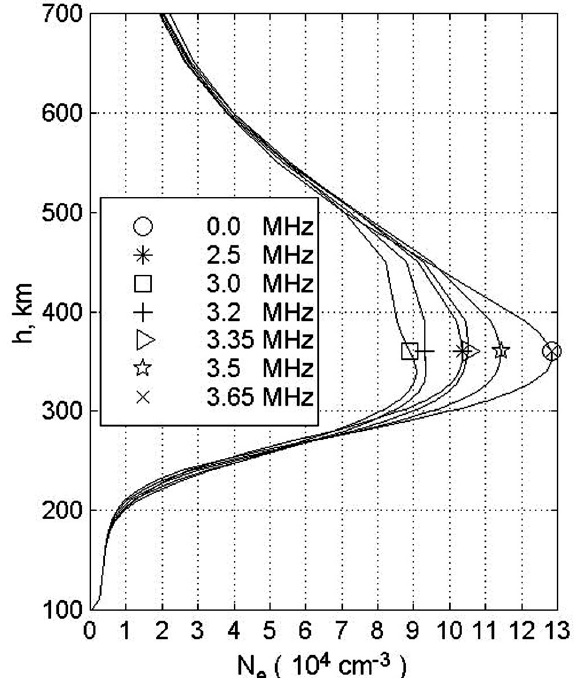
Fig. 7. Profiles of the electron concentration versus distance from the Earth along the geomagnetic field line, calculated for the point of the considered part of the convection trajectory which is located at S = 212 . 6km. The results are given for the same cases as in Fig.